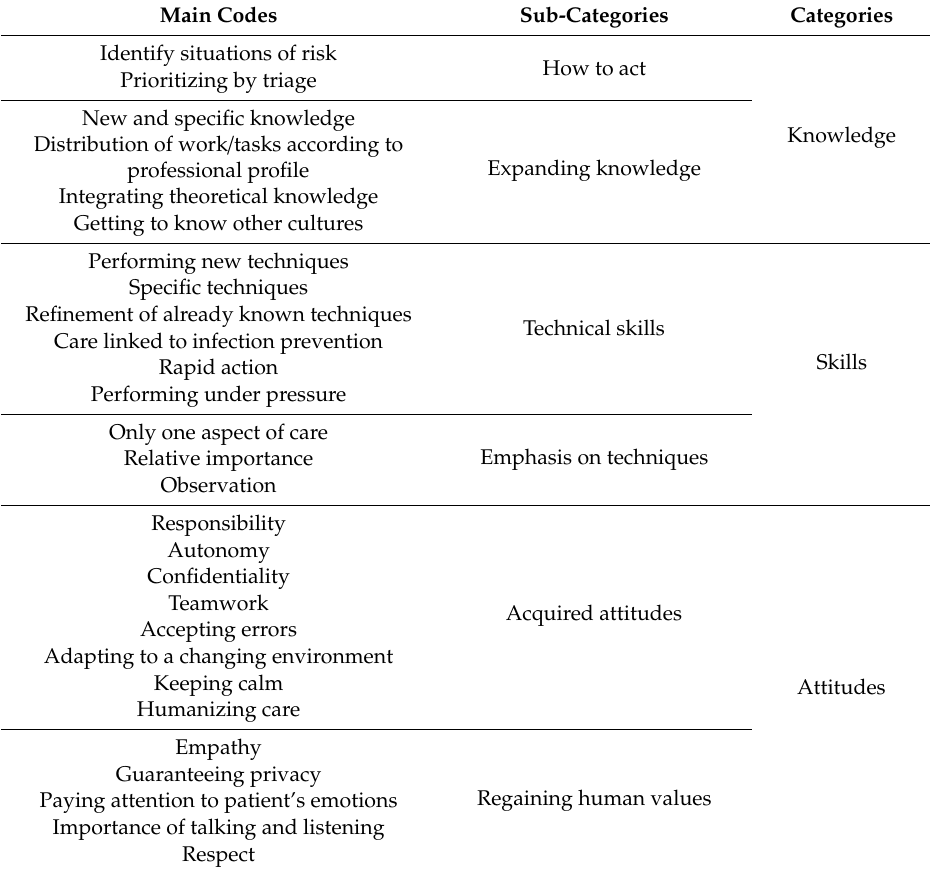
Table 2. Main categories, sub-categories and codes about the theme “importance of attitudes over and above